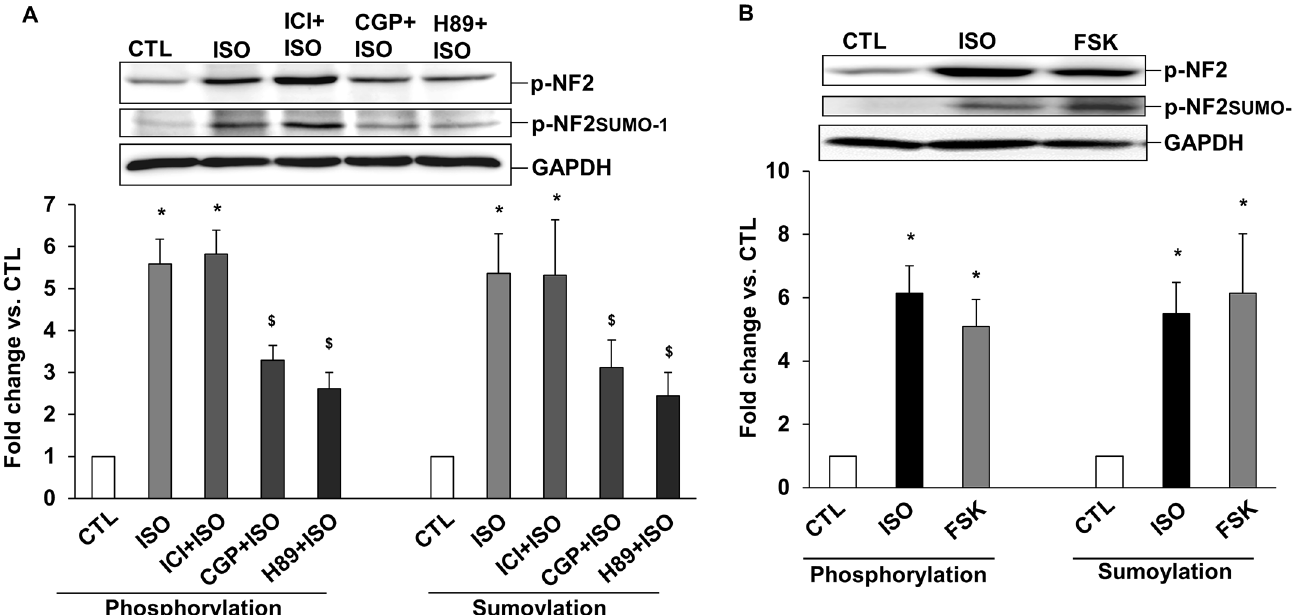
Fig 4. Involvement of β -AR subtypes, adenylyl cyclase and PKA in post-translational modifications of NF2. (A) ARVMs in CGP+ISO, ICI+ISO and H89+ISO groups were pretreated with CGP, ICI and H89, respectively, for 30 min prior to ISO treatment for 15 min. (B) ARVMs were treated with forskolin (FSK), an adenylyl cyclase activator, for 15 min. Cell lysates were analyzed by western blot using phospho-specific anti-NF2 antibodies. The lower panels exhibit the mean data normalized to GAPDH. (cid:3) p < 0.05 vs. CTL; $p < 0.05 vs. ISO; n = 6–9.